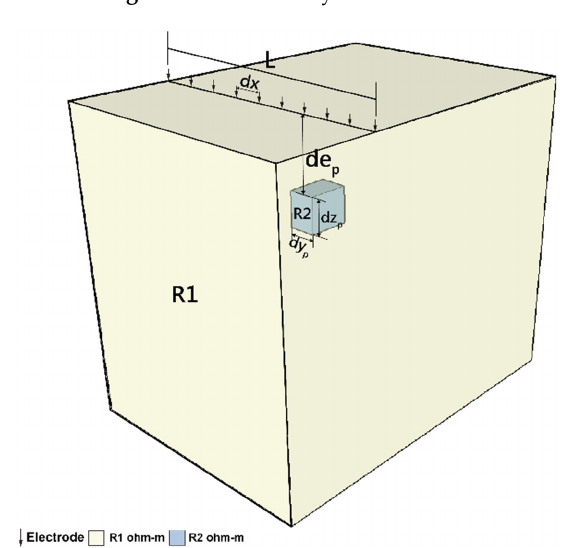
Figure 4. 2.5D boundary effect model. Table 2. The explanatory table of the boundary effect stratum model parameters.